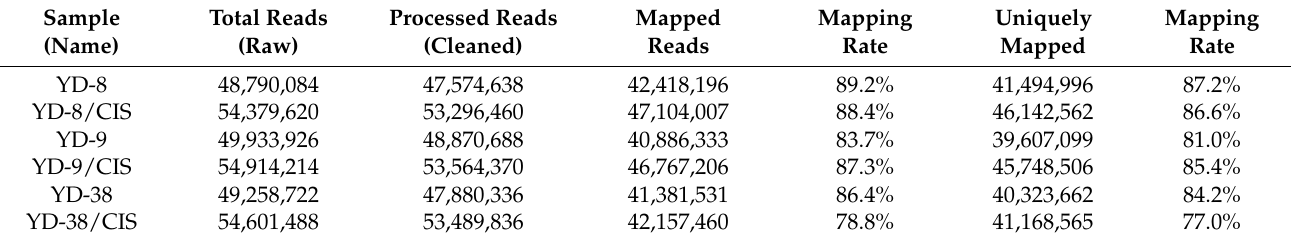
Table 1. Summary statistics of the sequencing analysis of the RNA-Seq